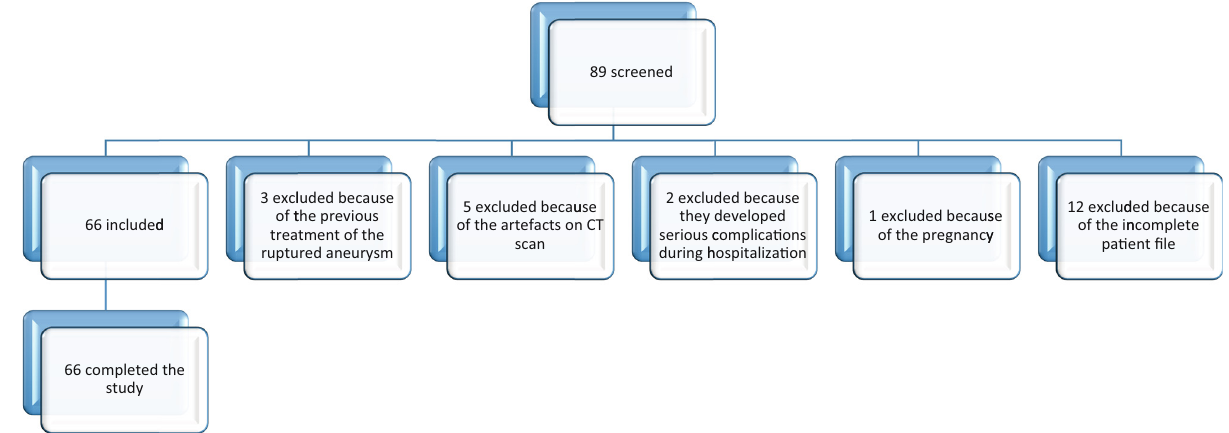
Figure 1: The study fl